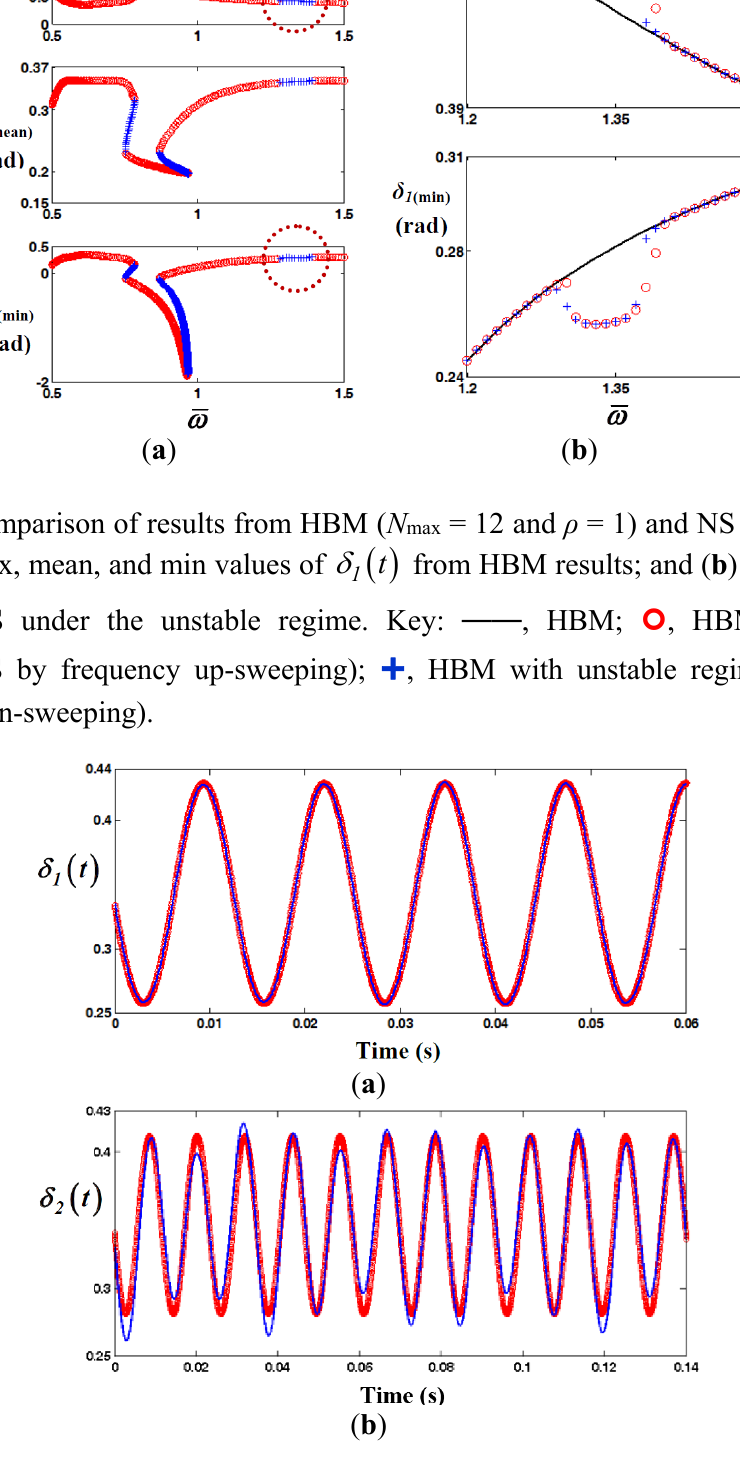
Figure 12. Time histories by HBM ( N max = 12 and ρ = 1) and NS at different excitation conditions: ( a ) time histories at  = 1.25; and ( b ) time histories at  = 1.35. Key:  , HBM; ━━ ,